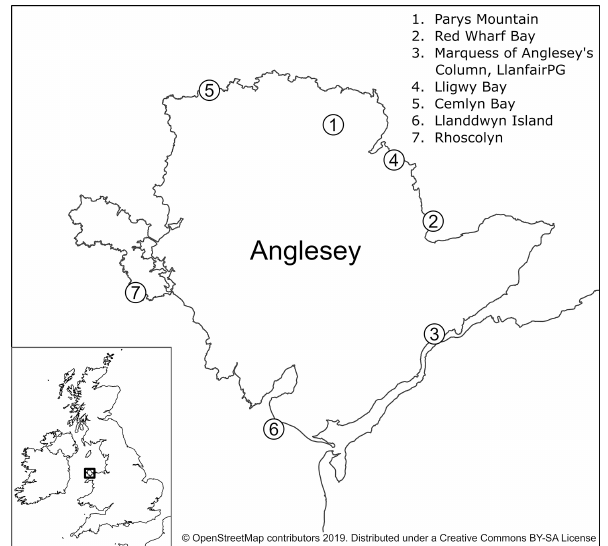
Figure 1. Island of Anglesey with field